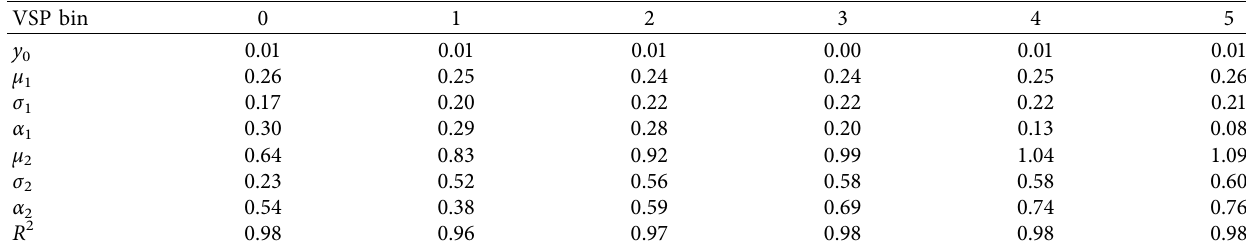
Table 2: Gaussian distribution ftting parameters for HEV VSP bins.